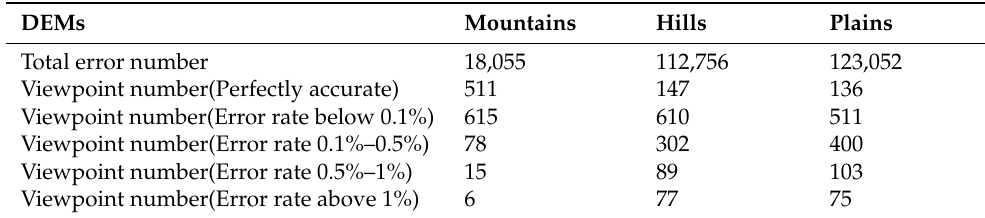
Table 2. Total error number and viewpoint number with different error rate with PDERL (with problem 1 solved) (Total viewpoint number: 1225).